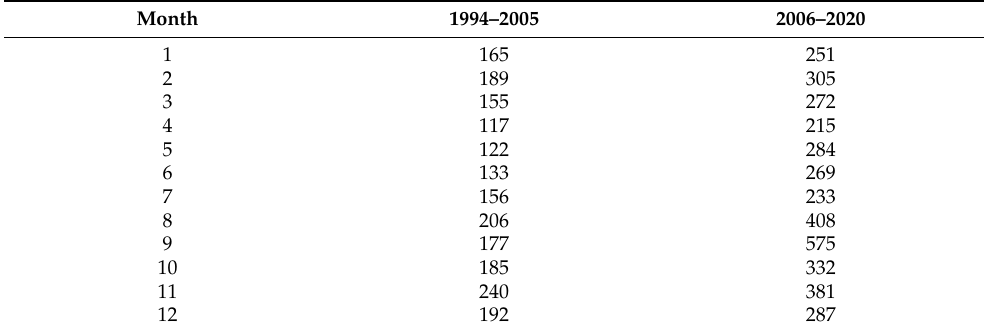
Table 8. Monthly means of TPout concentrations (ppb), as calculated for two periods, 1994–2005 and 2006–2020, when the migrated crane population maximum size varied between 17,000–27,000 and 33,000–56,100,